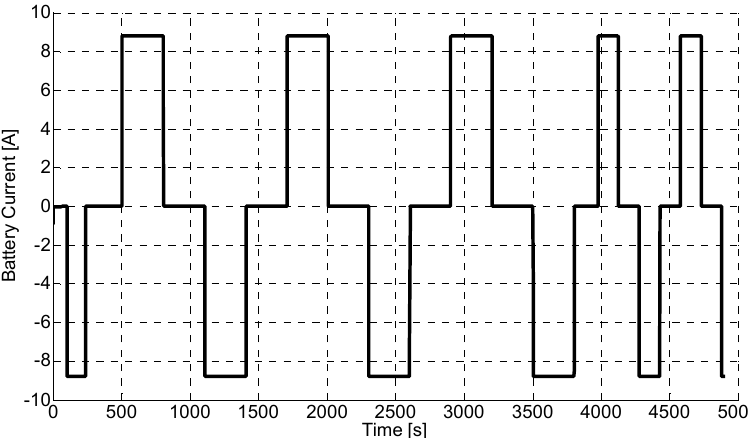
Figure 8. Current pattern used for test in dynamic